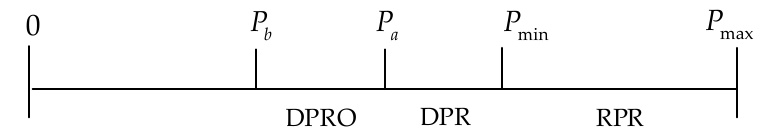
Figure 1. Three-stage peaking regulation process of thermal power unit: P max is the maximum output of the unit, P min is the minimum technical capacity of the unit at the stage of regular peak regulation (RPR), P a is the minimum rated capacity of the unit at the deep peak regulation without oil (DPR) stage, and P b is the minimum stable output at the deep peak regulation with oil (DPRO) stage.